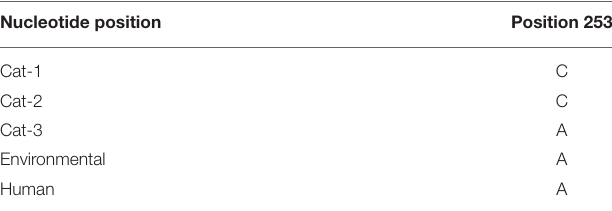
TABLE 3 | Polymorphic sites in the Staphylococcus aureus mecA gene. Nucleotide